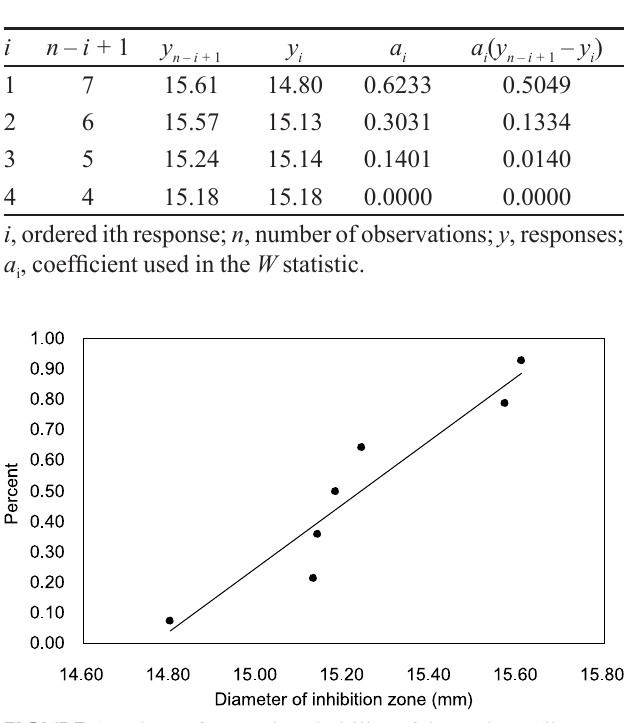
FIGURE 1 - Chart of normal probability of the S of inhibition zone, mm) at 20 µg mL -1 , for the ofloxacin microbiological assay After the statistical value AD was calculated, the p -value was calculated for the other treatment groups. Initially, cdf values were calculated, then, the p -value was obtained by subtracting (1 -